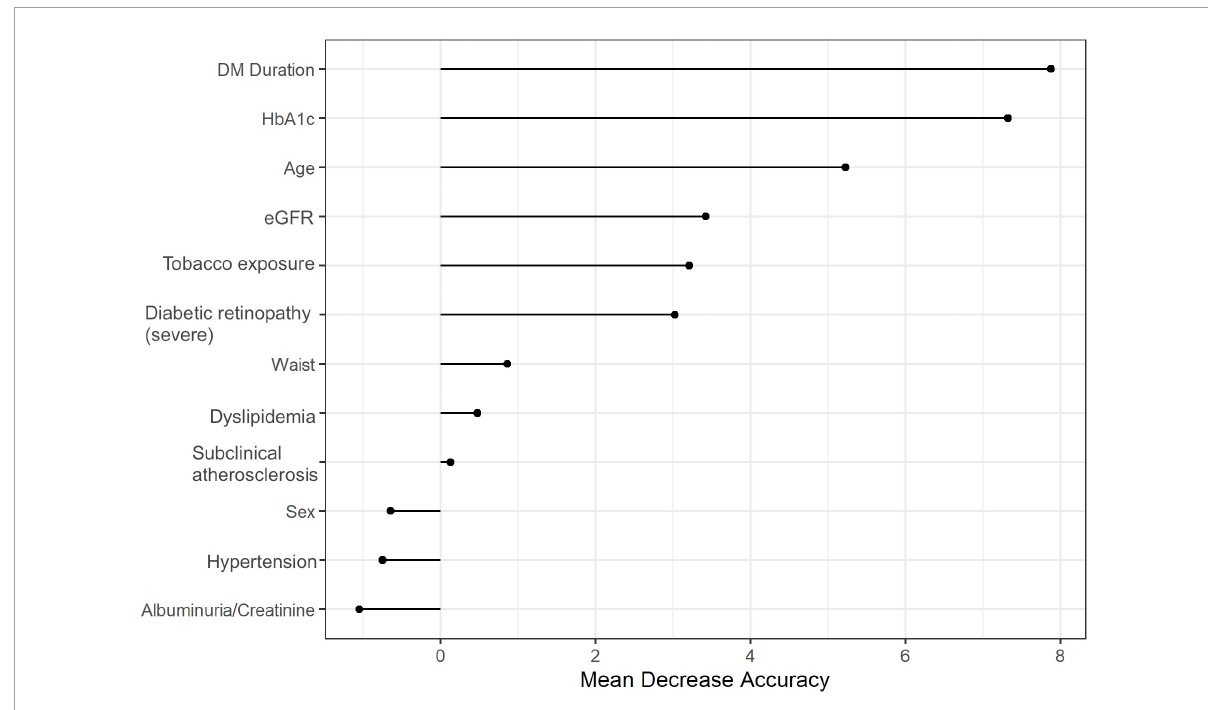
FIGURE2 Random forest of the relative importance of each variable in the multivariate predictive model for the association between severe diabetic retinopathy and the presence of subclinical atherosclerosis with cardiovascular events. DM_duration, diabetes mellitus duration; eGFR, estimated glomerular filtration rate; Plaque, presence of carotid plaques. Diabetic retinopathy severe, reference group: no or mild diabetic